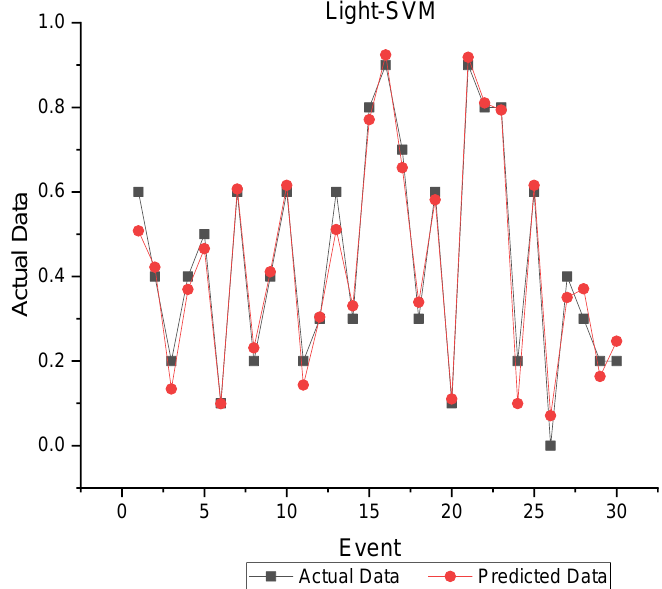
Figure 15. Representation of actual and prediction data for light SVM. Figures 16–18 show the graphs for the actual data and prediction data for pump, fan, and light using the multilayer perceptron (MLP) algorithm, respectively.